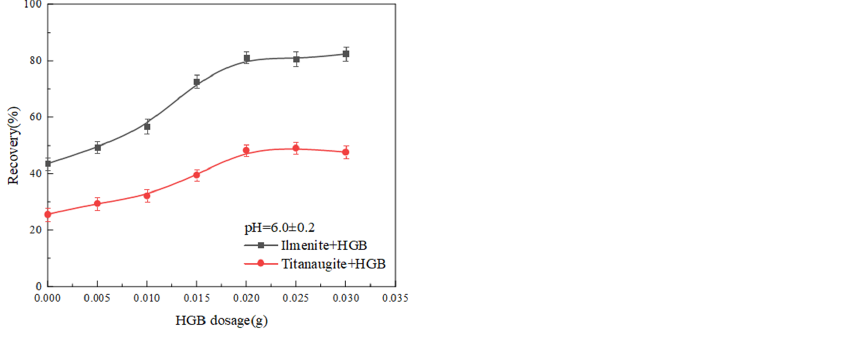
Figure 5. Effect of HGB dosage on fine ilmenite and fine titanaugite recoveries (the mineral size distributions of 0–19 µm, 4.0 × 10 −4 mol·L −1 sodium oleate).